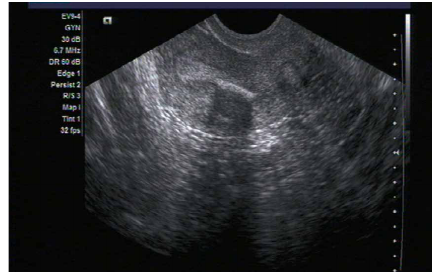
Figure 1: Transvaginal image of the uterus: intrauterine retention of fetal bone.